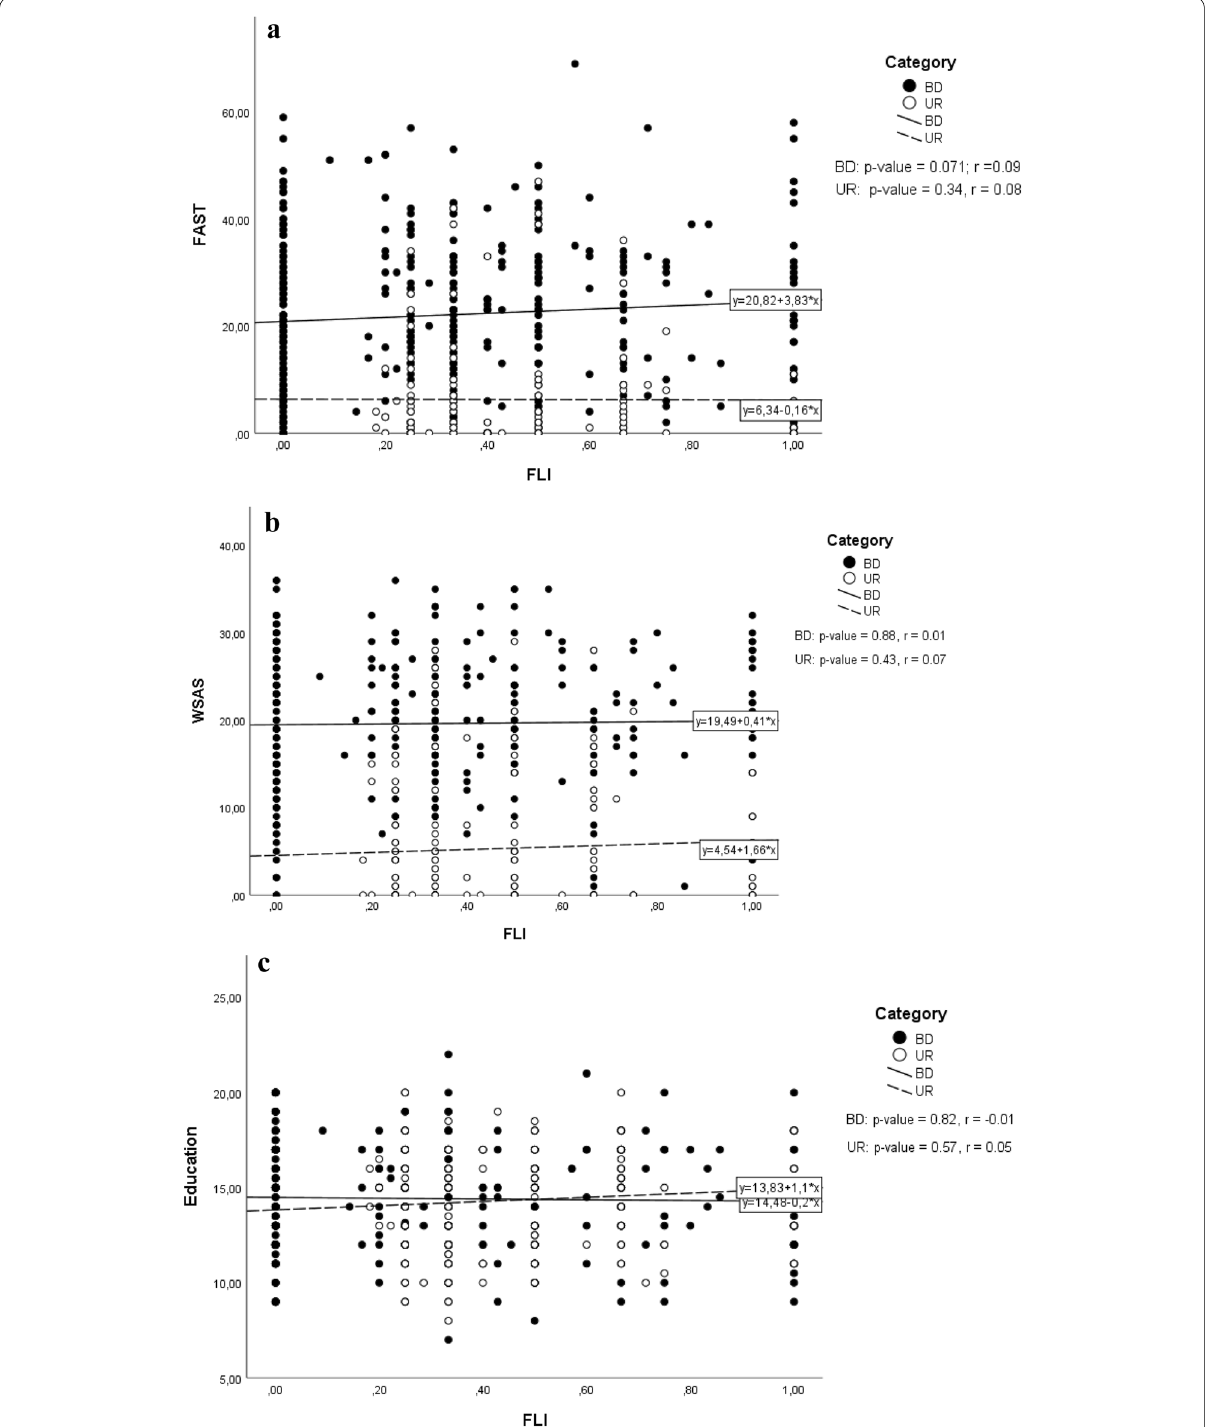
Fig. 1 Associations between Family Liability Index (FLI) and a Functioning Assessment Short Test (FAST), b Work and Social Adjustment Scale (WSAS) and c Educational achievement (years of education) in 388 patients newly diagnosed with bipolar disorder (BD) and 144 of their unaffected first-degree relatives